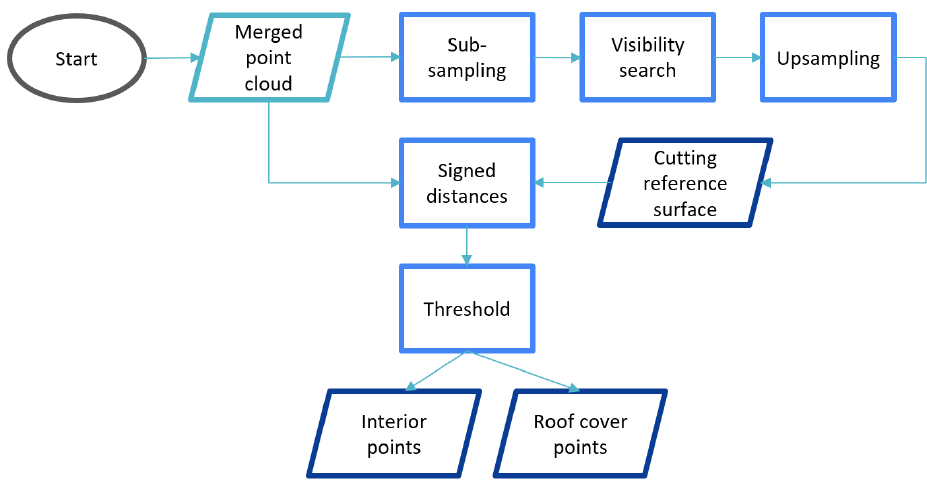
Figure 3. Workflow of roof cover filtering.